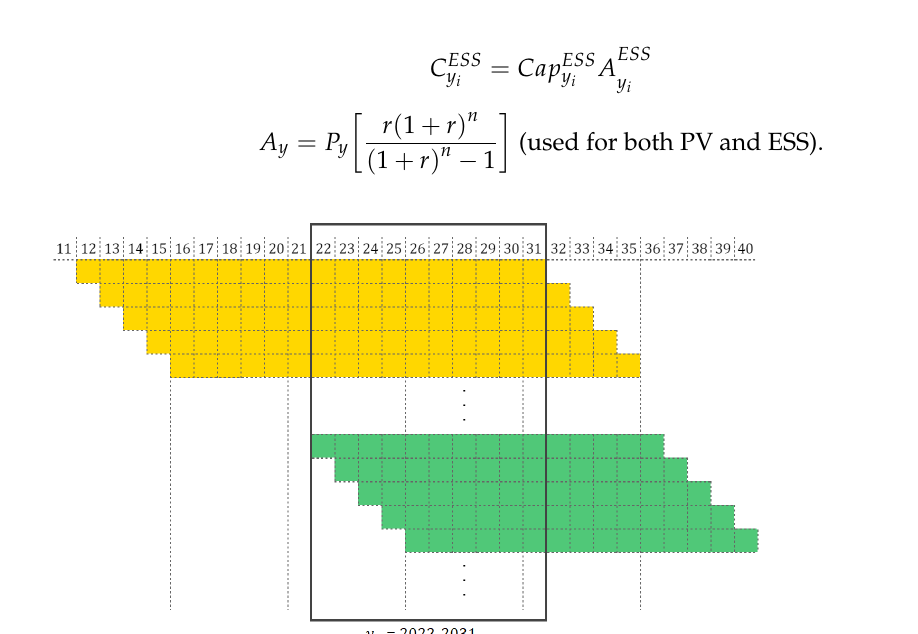
Figure 10. Visualization of the elements of the LCOG. Each box represents an annuity cost either from PV (yellow) or ESS (green). The bounded box represents the planning horizon in this study.